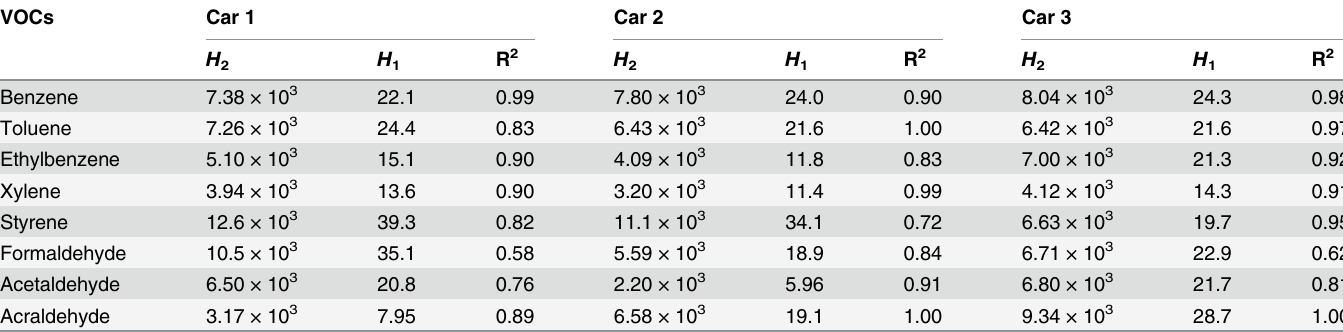
Table 2. Linear curve fitting results using the derived correlation to treat the experimental data in the three tested cars.